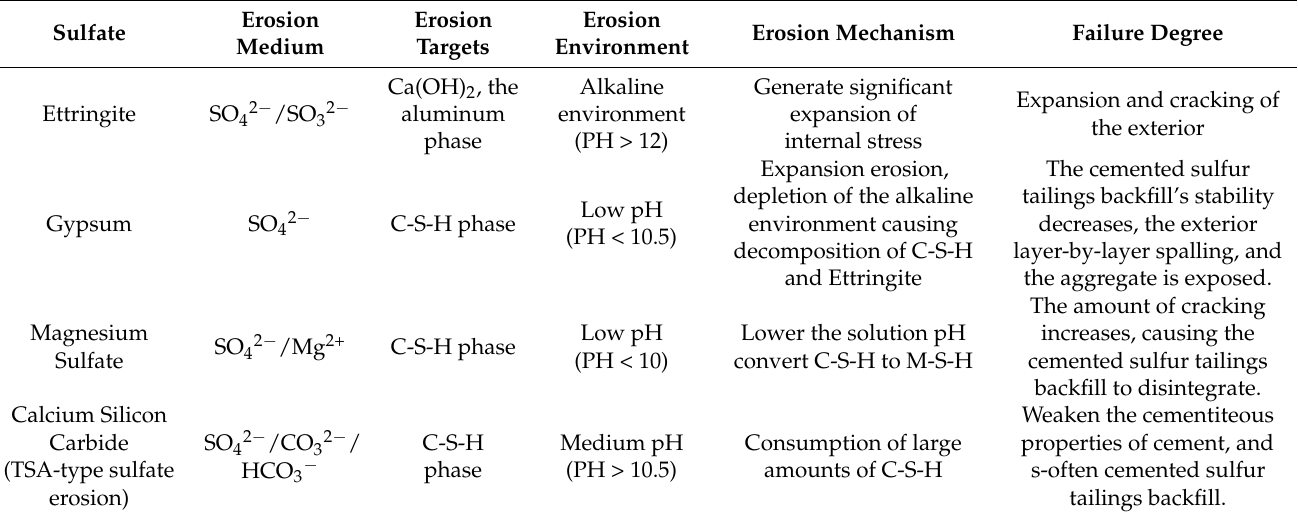
Table 1. Main types of sulfate attack.